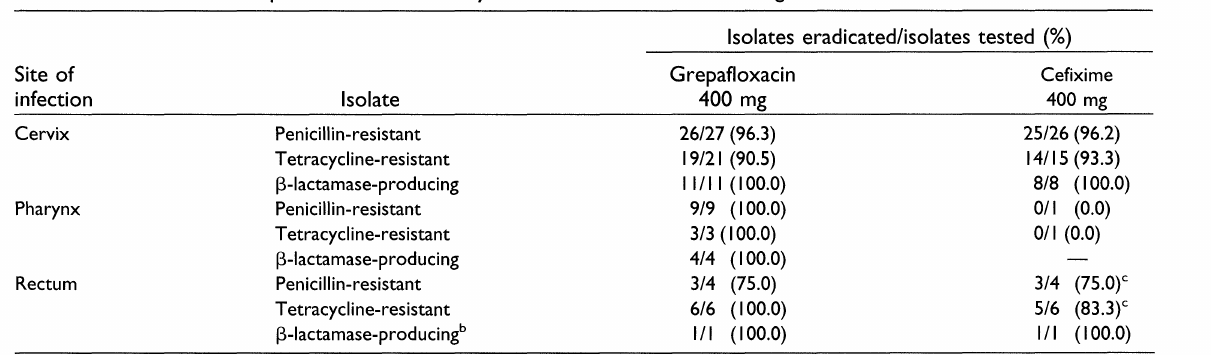
TABLE 2. Eradication of penicillin- and tetracycline-resistant isolates of N. gonorrhoeae Site of